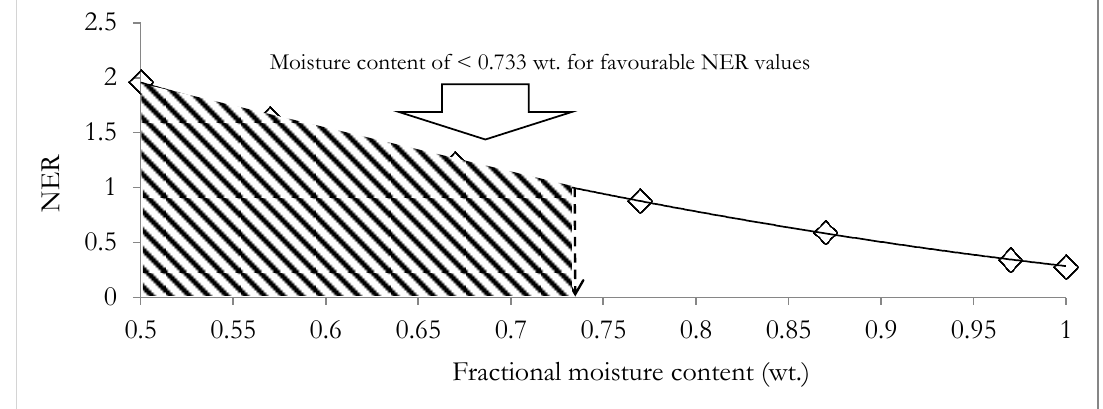
Figure 10. Variation of the net energy ratio (NER) of the integrated hydrothermal liquefaction and anaerobic co-digestion system and the moisture content of the digestate.